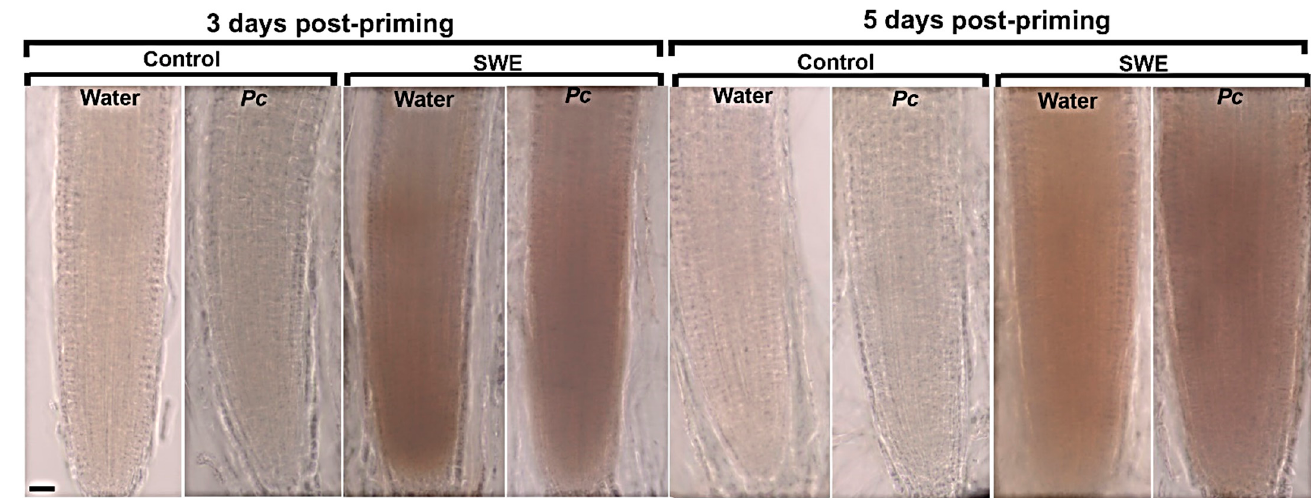
Figure 8. Hydrogen peroxide detection in A. thaliana roots at 3 and 5 days post-priming. Plants were exposed to two